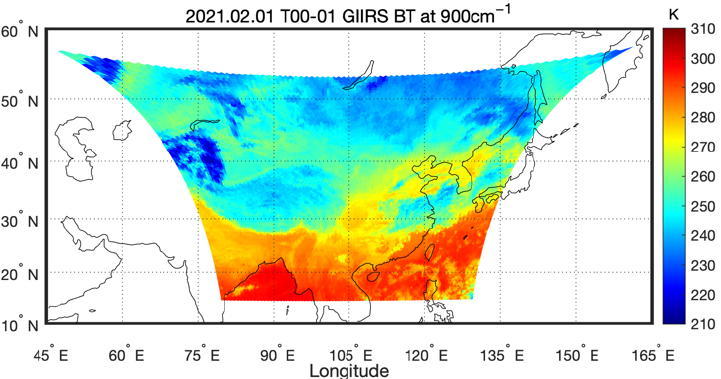
Figure 5. The GIIRS observed 900 cm − 1 brightness temperatures (unit: K) for the China area from 00 to 01 (UTC) on 01 February 2021.